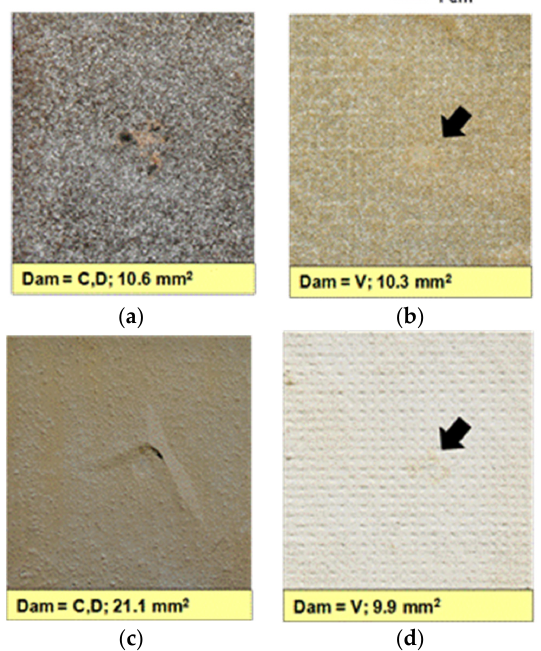
Figure 7. Images of impact damage and damage observations (see inset description) on the front (impacted side) of ( a ) CRE ‐ P/FlekS, ( b ) CRE ‐ Semi/Flek, ( c ) CRE ‐ P/ReS and ( d ) CRE ‐ Semi/Re samples after 5 J drop ‐ weight impact tests. Damage observation (Dam) is as follows: V, visible surface damage (the coating is damaged by impact tup at a local area); D, debonding of coating, and; C, cracking of coating. Area of the damage (measured by image analysis software) is given as mm 2 . Table 5. The impact and flexural moduli for all CRE composite laminates.